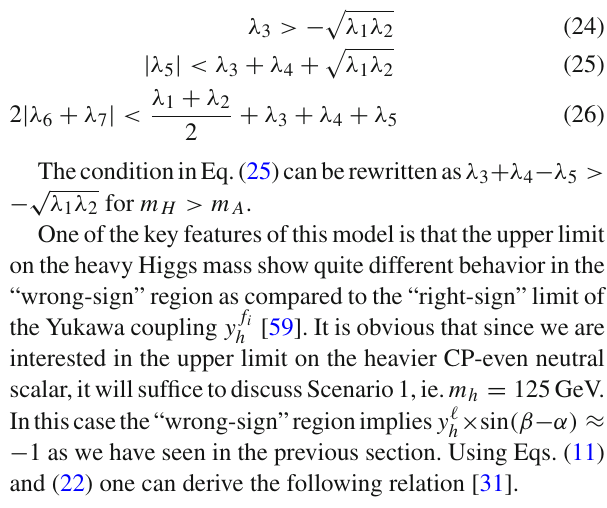
Fig. 3 Allowed parameter space in m H ± − m A plane consistent with theoretical bounds